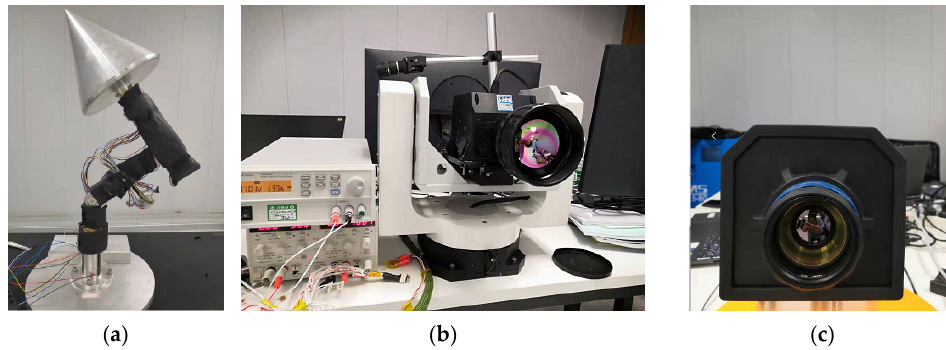
Figure 15. Physical diagram of the platform and two infrared detectors. ( a ) the physical diagram of the semi-physical simulation platform; ( b ) the infrared detector 1; ( c ) the infrared detector 2. In this experiment, the ball-base-cone is taken as an example. The height of the cone Table 9. Parameters setting of the two infrared detectors. is 20 cm, the radius of the hemisphere is 5 cm, its surface material is a black film, and the emissivity is 0.85. During the experiment, the temperature of the target was maintained at 40 °C the coning period was 1.5 s and the spin period was 0.9 s. The distance between the target and detector was 10.9 m. The images after reshaping in the two infrared bands of the target are shown in Figure 16.